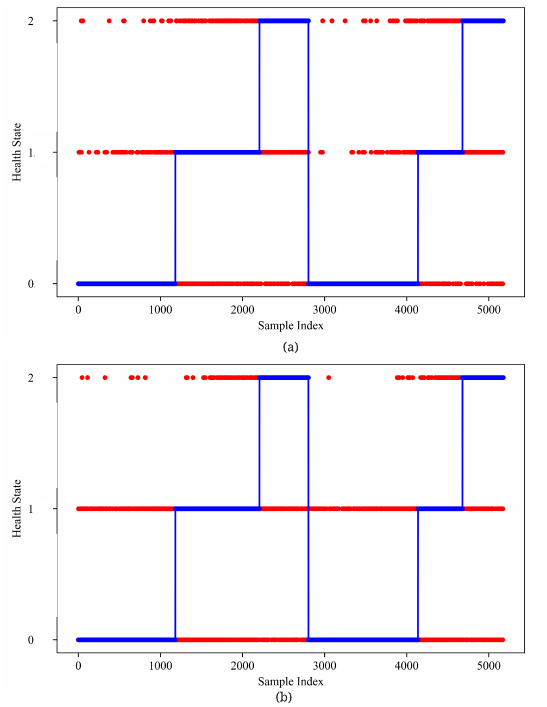
Figure 15. Health state prediction of five models ( a ) LSTM; ( b ) GRU. Samples from bearing 1_1 and bearing 1_3 are joint from left to